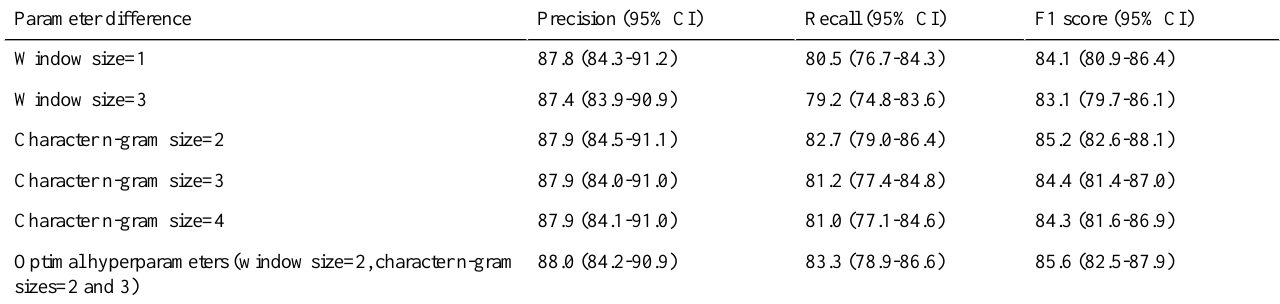
Table 6. Results of varying certain feature extraction